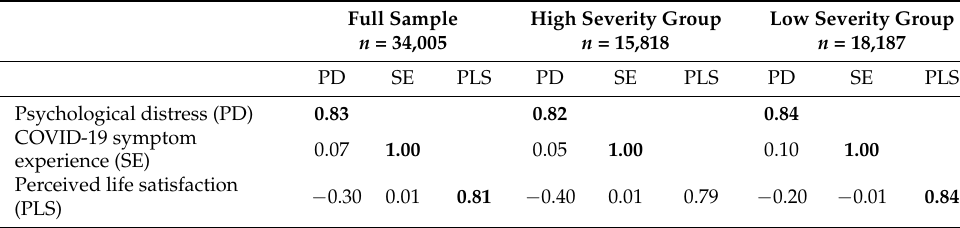
Table 2. Correlations and square roots of AVE values.